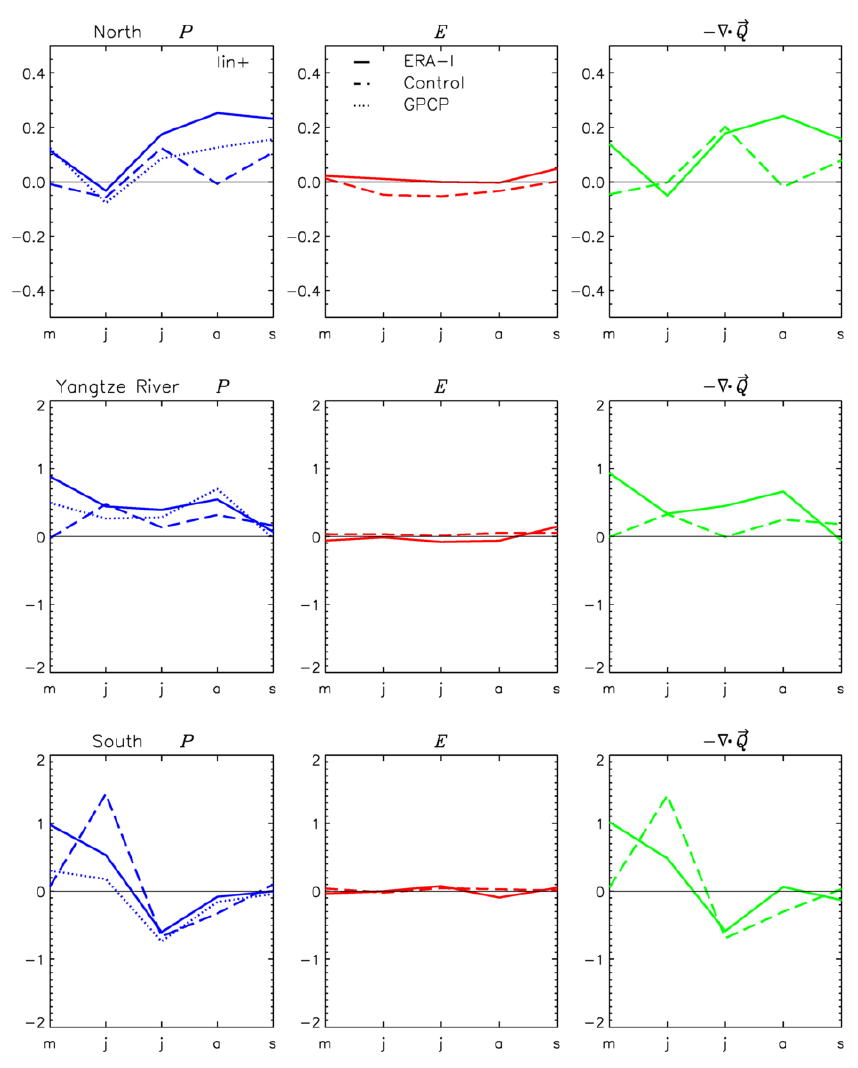
Figure 9. Impact of the WPSH intensity variability in the main atmosphere water budget components over the north (top), Yangtze River (middle) and south (bottom) domains. Anomalies (composites − mean state) of precipitation (left panels), evaporation (middle panels) and moisture convergence (right panels) are calculated for May–September I IN + composites for ERA-I (solid lines) and AMIP-N96 Control (dashed lines). Left panels also show precipitation anomalies for GPCP (dotted lines). All values are expressed in mmday − 1